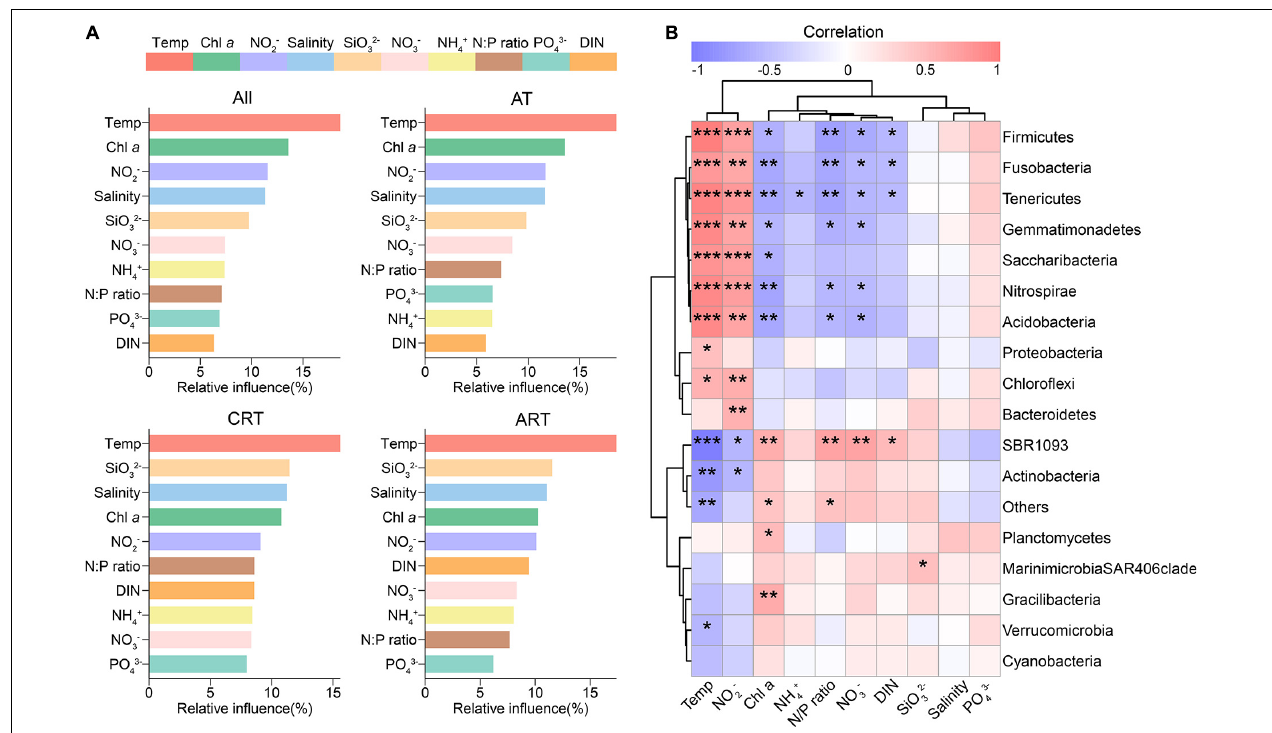
FIGURE 5 | Drivers shaping the microbial communities. (A) Aggregated boosted tree (ABT) showing the relative contribution of environmental factors on the community composition. (B) The relationships between sea water properties and the relative abundances of microbial phyla based on Spearman correlation (* p < 0.05; ** p < 0.01; *** p <